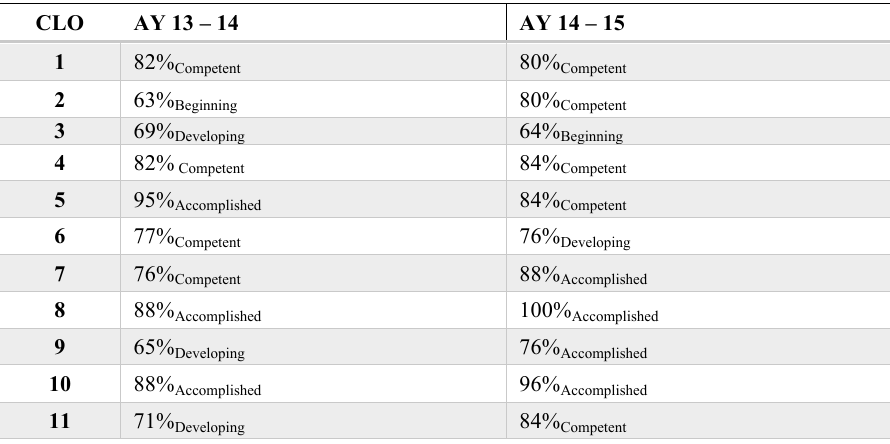
Table 7. Attainment scores for the CLOs of the Electric Circuits (EC) course over two assess- ment